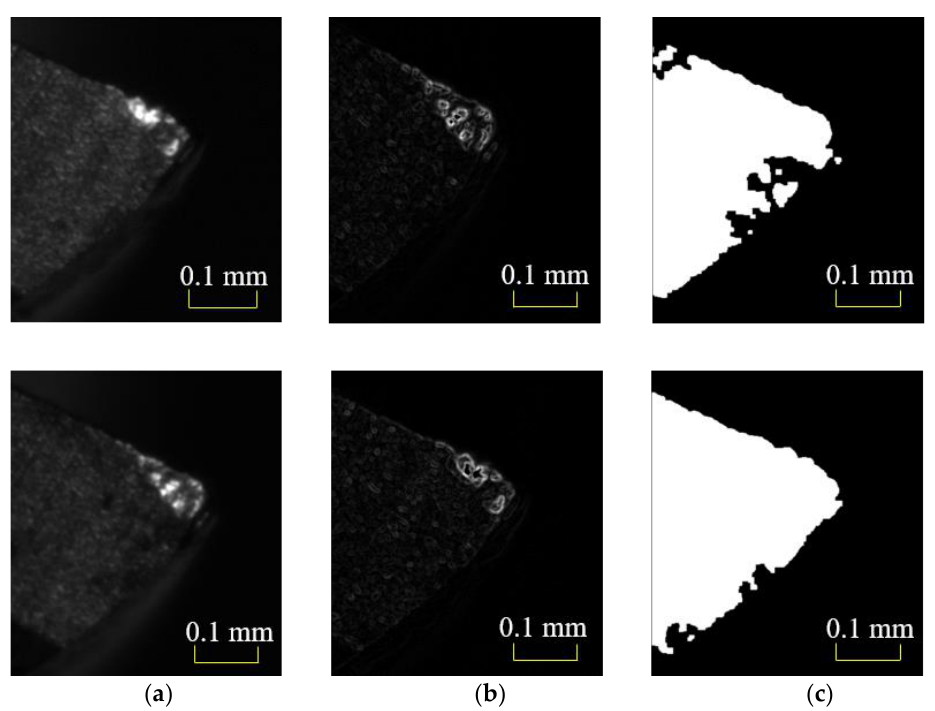
Figure 9. Image presegmentation process. ( a ) Original image; ( b ) Sobel preprocessing results; ( c ) Sobel + Otsu segmentation result.